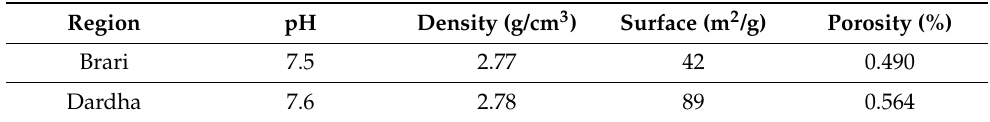
Table 2. Physicochemical parameters of natural clays originating from two regions of Albania (Kledi